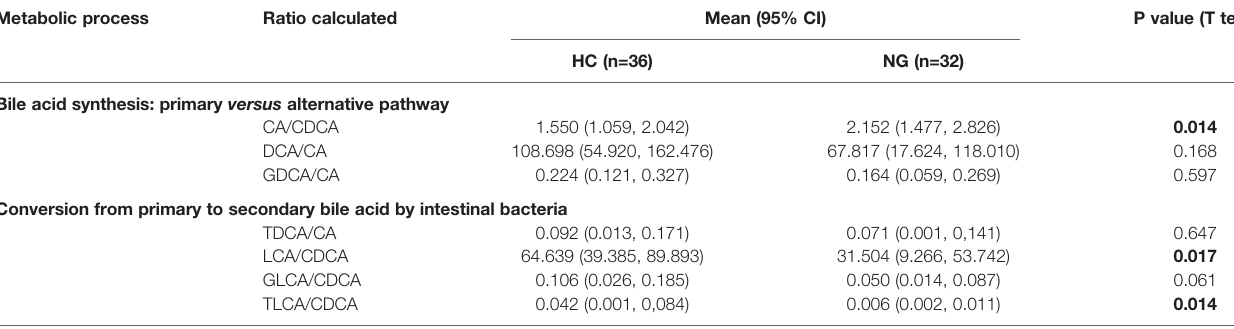
TABLE 2 | Ratios of bile acids re fl ecting the enzymatic activities in the gut microbiota and liver. Metabolic process Ratio calculated Mean (95% CI) P value (T test) HC (n=36) NG (n=32)